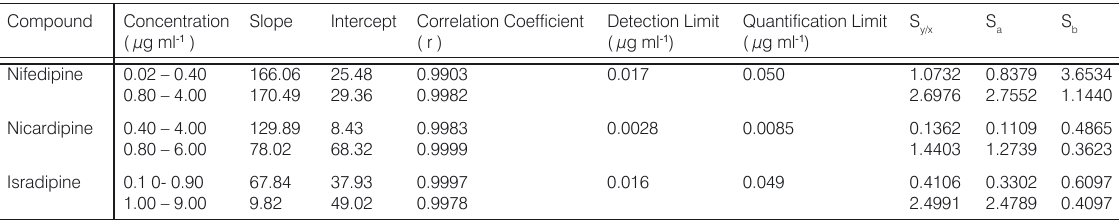
Table 1. Analytical performance data of the proposed spectroflourometric method for nifedipine, nicardipine and isradipine in pure form.